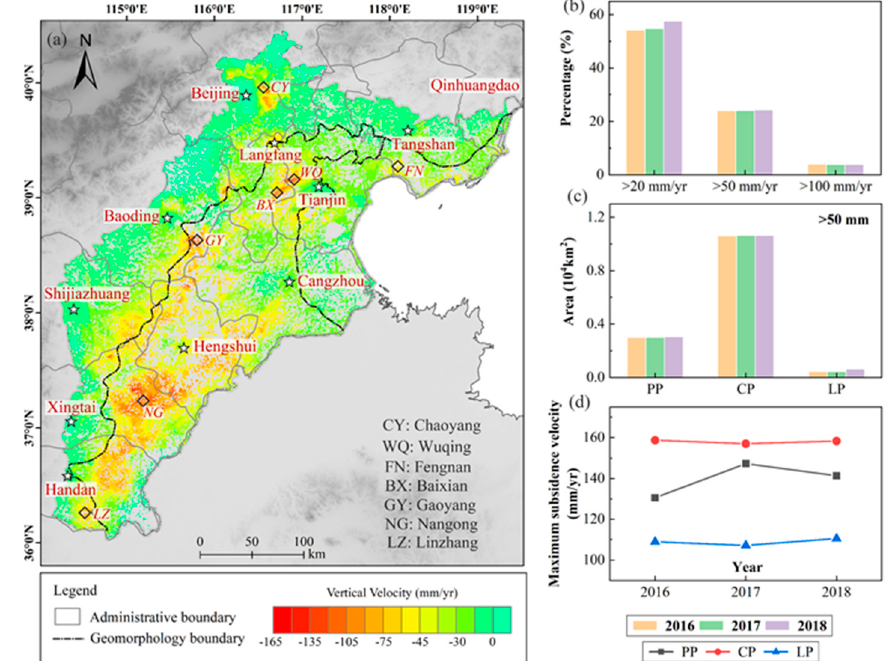
Figure 3. ( a ) Mean vertical displacement velocities throughout the NCP derived from the Sentinel-1A (S1A) data by using persistent scatterer interferometric synthetic aperture radar (PS-InSAR), ( b ) statistics of the subsidence rates at persistent scatterer (PS) points, ( c ) changes in the area with subsidence over 50 mm from 2016 to 2018, and ( d ) changes in the maximum subsidence rates from 2016 to 2018: PP, CP, and LP represent the piedmont alluvial-proluvial plain, central alluvial-lacustrine plain, and littoral plain, respectively.